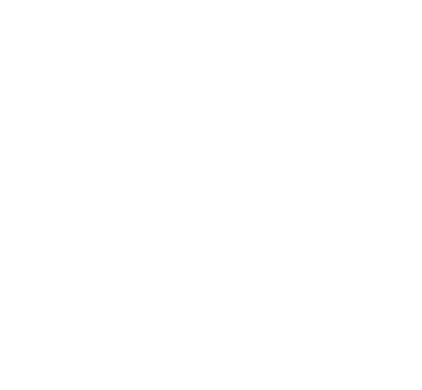
Figure 1. The sorafenib plasma concentration–time profiles in rats receiving sorafenib (II SOR ) and sorafenib + morphine (I SOR+MF ).